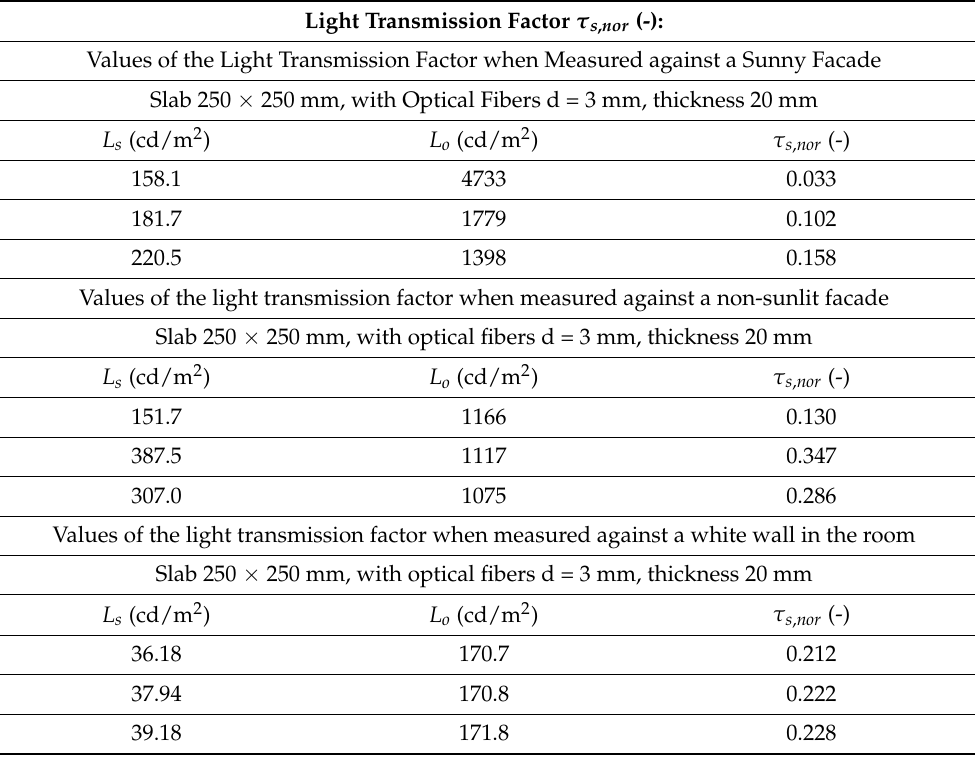
Table 4. Light transmission factor τ s , nor (-). Light Transmission Factor τ s , nor (-): Values of the Light Transmission Factor when Measured against a Sunny Facade